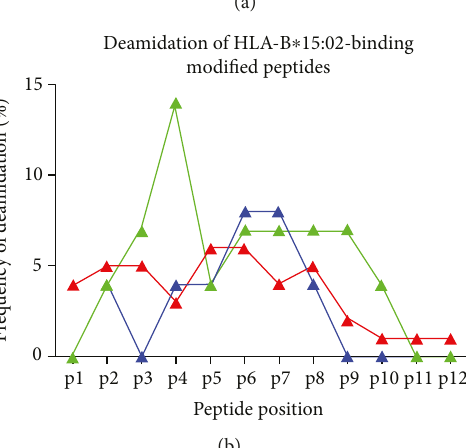
Figure 4: Deamidation at p4 is altered after treatment with EPX for B ∗ 15:02. (a) Given is the amount of modi fi ed peptides presented by B ∗ 15:02 w/o treatment (blue), after treatment with CBZ (red) and EPX (green). (b) Frequency of deamidation of modi fi ed peptides derived from B ∗